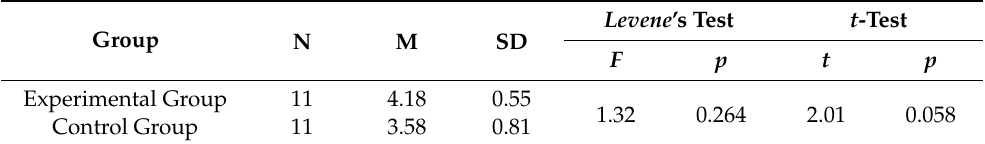
Table 3. The independent sample t -test result of the learning attitude for the two groups before the experiment.